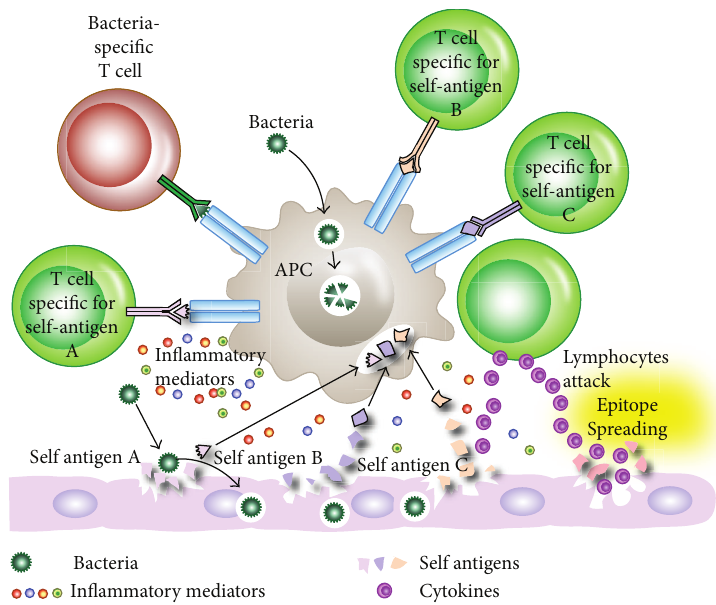
Figure 6: Bacterial infection induces release of tissue antigen and presentation of bacterial and self-tissue antigens resulting in the induction of autoreactive T cells. T cells and inflammatory mediators cause the release of more self-antigens which differ from the original antigens. T-cell responses can then spread to involve T cells specific to other self-antigens. This T-cell response against different epitopes results in antibody production against multiple tissue